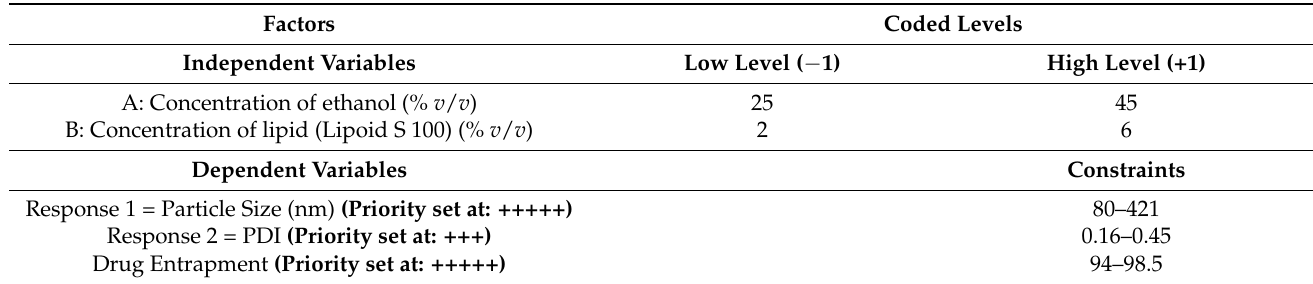
Table 4. Lists of dependent variables and independent variables for the formulation. It also enlists the range of formulation variables used for the optimization of the